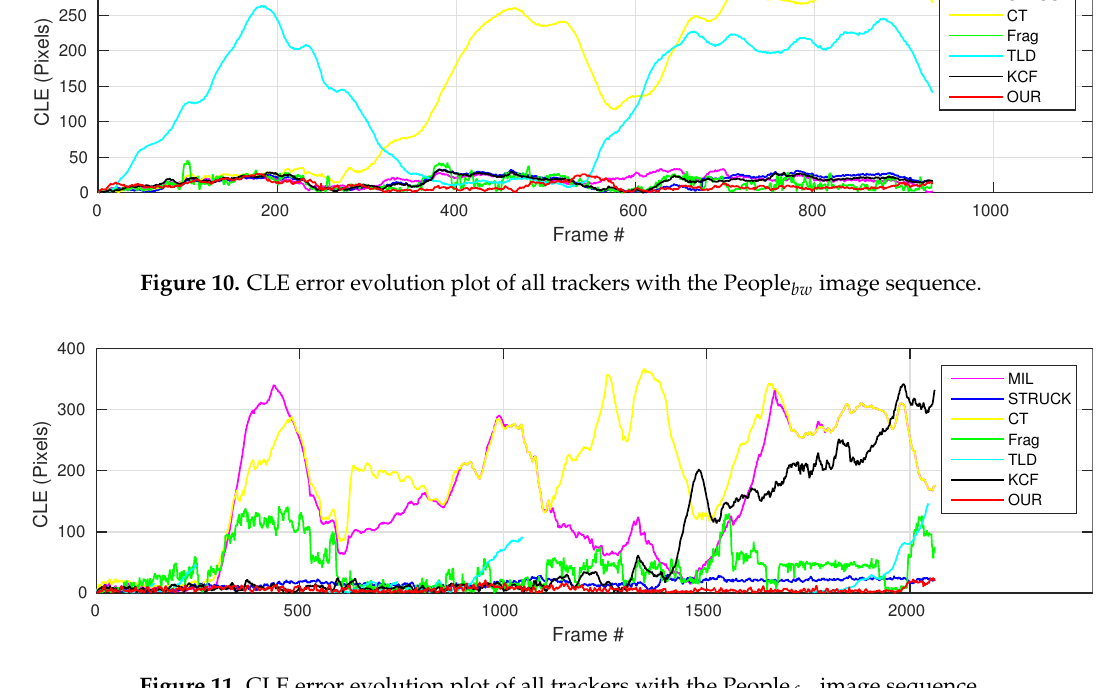
Figure 11. CLE error evolution plot of all trackers with the People fw image sequence. Table 3. Center location error (CLE) (in pixels) and frames per second (FPS). Red, blue and green fonts indicate the best, second best and third best performances in all visual trackers. The total number of evaluated image frames in this paper is 11,646.